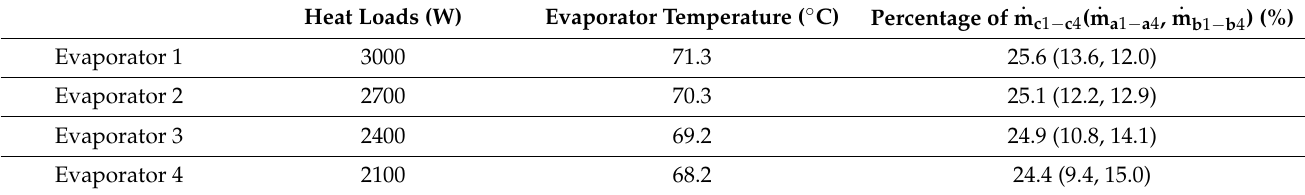
Table 2. Calculation results of operating temperature and the mass flow rate in each flow path for each